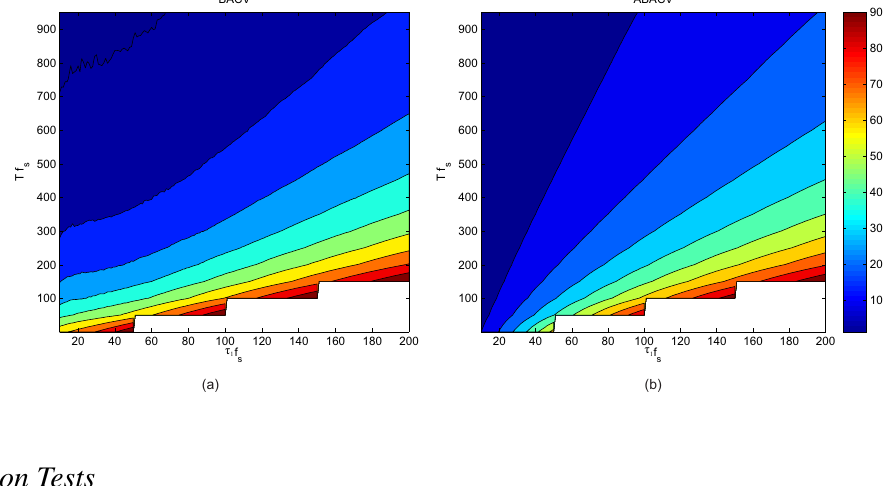
Figure 13. Relative energy consumption of ( a ) BACV and ( b ) ABACV, the energy consumption of the sensor that is awake all the time being 100%.